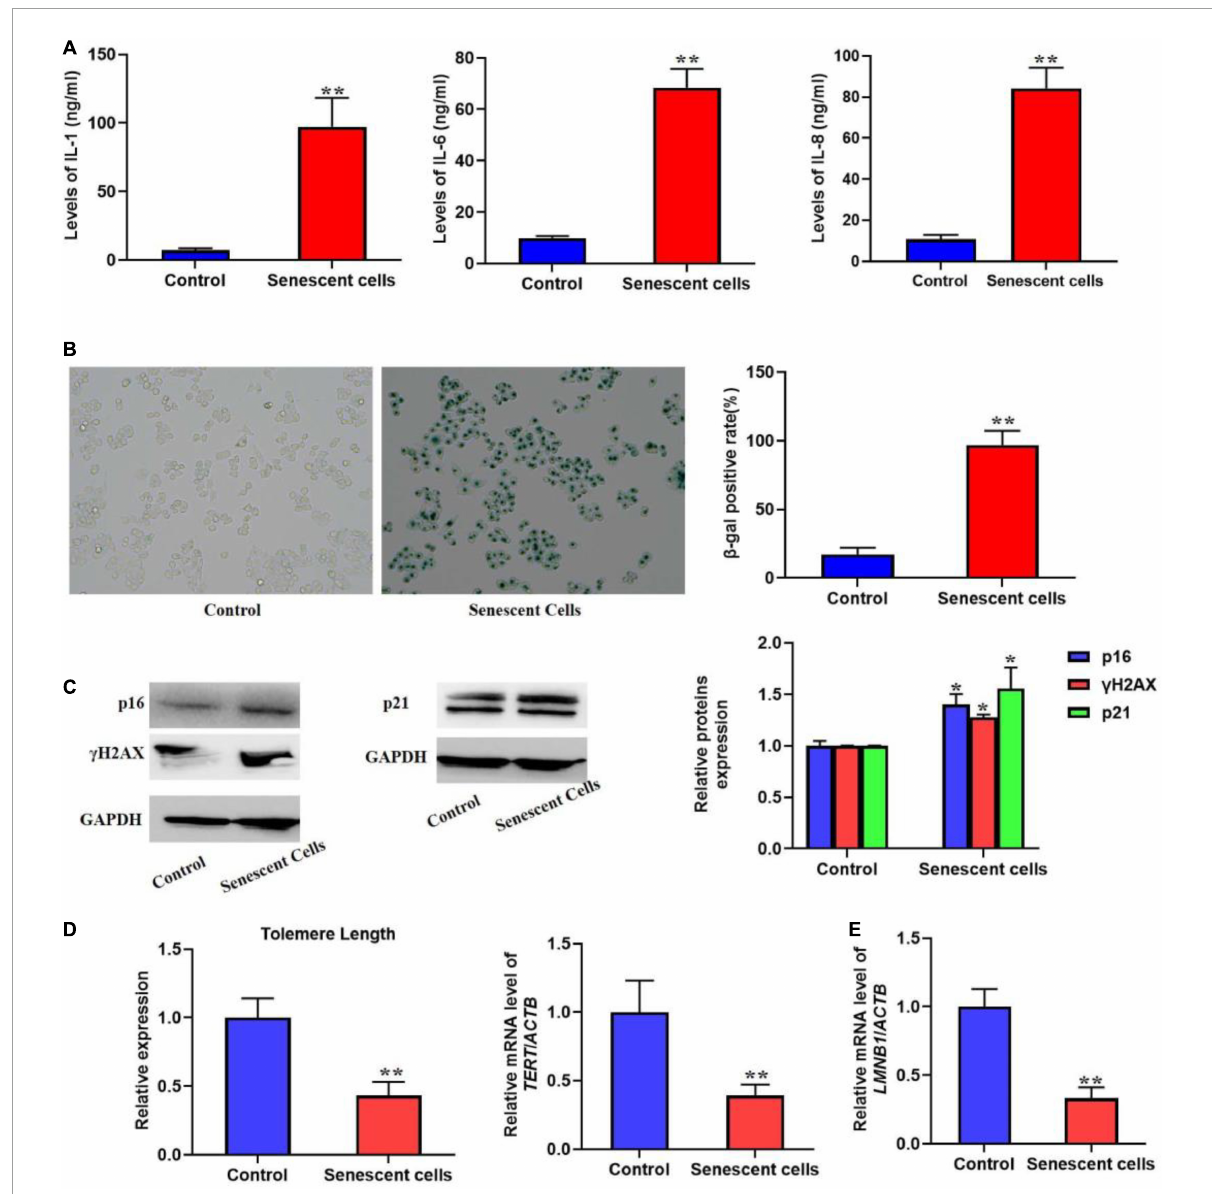
FIGURE1 Replicative senescent cells secreted SASP. The L02 hepatocytes were cultured for 20 weeks. (A) The secretion of IL-1, 6, and 8 were significantly increased in the supernatant. (B) The SA- β -gal activity was elevated. (C) The protein expression of p16, p21, and γ H2AX. (D) The change of telomere length. (E) The mRNA level of LMNB1 . All the data in this article were from three independent experiments ( N = 3). *Compared with control, p < 0.05; **compared with control, p < 0.01. The control cells of replicative senescent cells were young cells with lower PDL ( < 30) ensuring there is no replicative